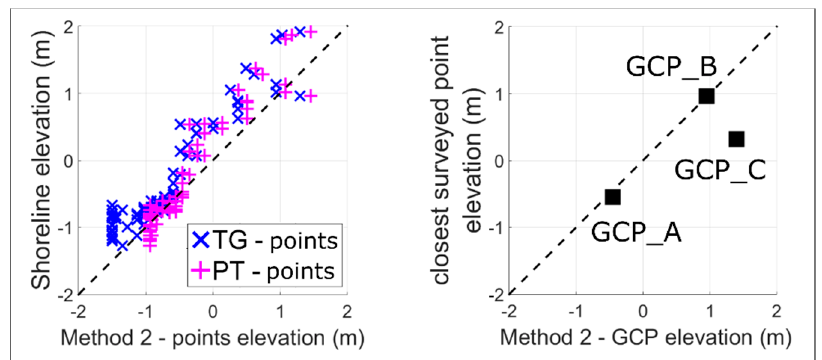
Figure 8. Accuracy of Method 2 in retrieving points elevation. Left : comparison between the shoreline elevation and the field-surveyed elevation of the specific intercepted 79 points. Right : relation between GCP elevation found by Method 2 and the closest point surveyed in the field. Dashed lines represent identity.